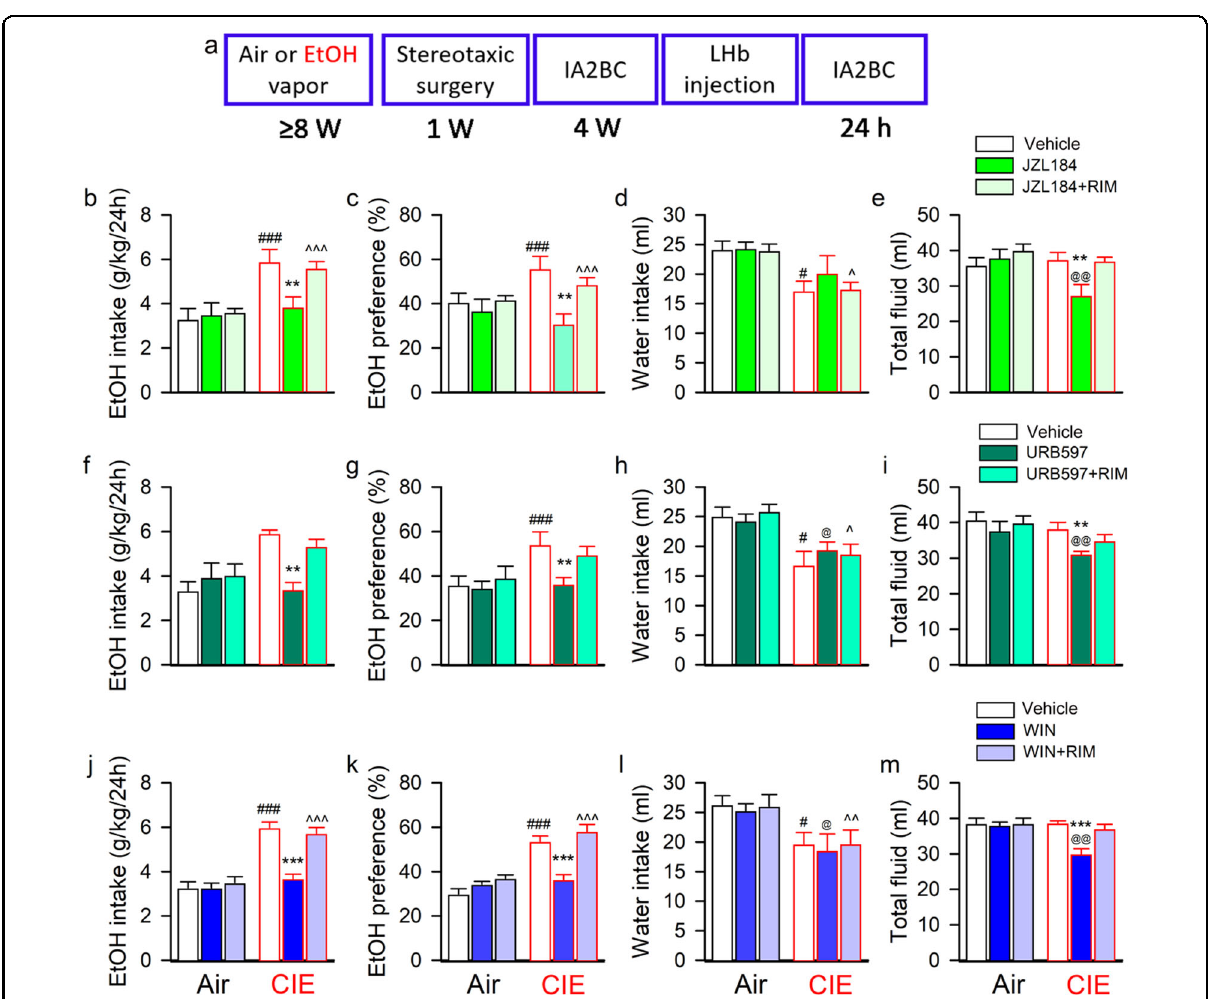
Fig. 4 LHb eCB-degrading enzyme inhibition or CB1 receptor activation decreases voluntary alcohol consumption in rats with a chronic intermittent ethanol vapor exposure history. Panel ( a ) is the schematic diagram showing the experimental timeline. Adult male Long-Evans rats were intermittently exposed to either ethanol vapor (CIE) or air for 8 weeks, followed by voluntary drinking in the intermittent access to 20% ethanol 2-bottle free-choice (IA2BC) paradigm for 4 weeks. At 24-h abstinence from the last drinking session, JZL184 (5 μ g/200 nl/side; b – e ), URB597 (4 μ g/ 200 nl/side; f – i ) or WIN 55,212-2 (WIN, 4 μ g/200 nl/side; i – k and m ) alone or with rimonabant (RIM, 2 μ g/200 nl/side), was bilaterally injected into the LHb 30 min before the beginning of a drinking session. The effect of LHb administration of these compounds on ethanol consumption was summarized in panels b-m. All data are expressed as mean ± SEM, n = 11 – 12/group for each compound. ** p < 0.01, *** p < 0.001 vs Vehicle or JZL184/URB597/WIN + RIM within group; # p < 0.05, ## p < 0.01, ### p < 0.001 vs same treatment among distinct grou p s, revealed by two-way RM ANOVA followed by Bonferroni post-hoc